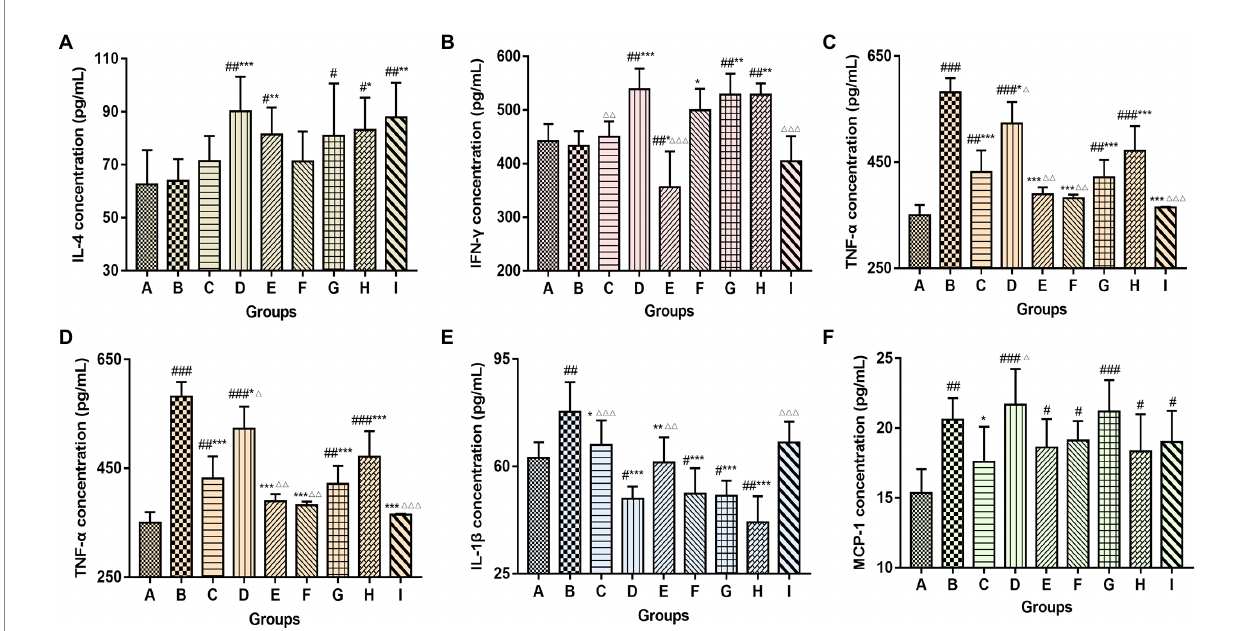
FIGURE 8 Changes in serum cytokine content ( A , IL-4; B , IFN- γ ; C , TNF- α ; D , IL-12; E , IL-1 β ; F , MCP-1) among groups. The significant differences were defined between the PBS group and the vaccination groups ( # p < 0.05, ## p < 0.01, ### p < 0.001), and between the influenza vaccination alone group and the other vaccination groups (* p < 0.05, ** p < 0.01, *** p < 0.001), and between the influenza vaccine and Astragali Radix co-immunized group and other TCM-adjuvant groups ( △ p < 0.05, △△ p < 0.01, △△△ p <